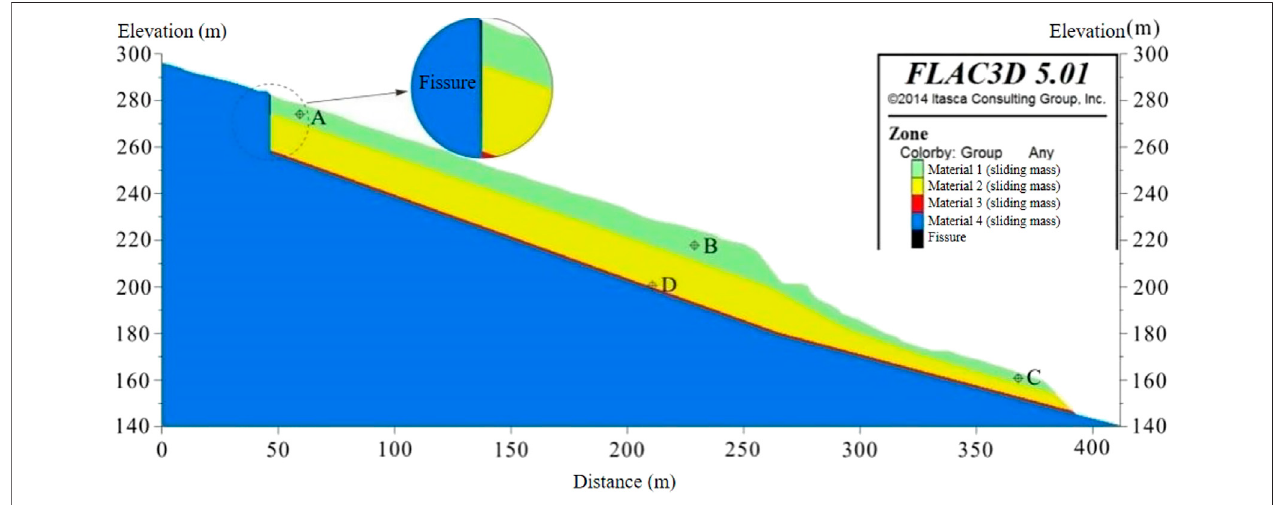
FIGURE 14 | Average velocity of each unit of sliding zone soil.